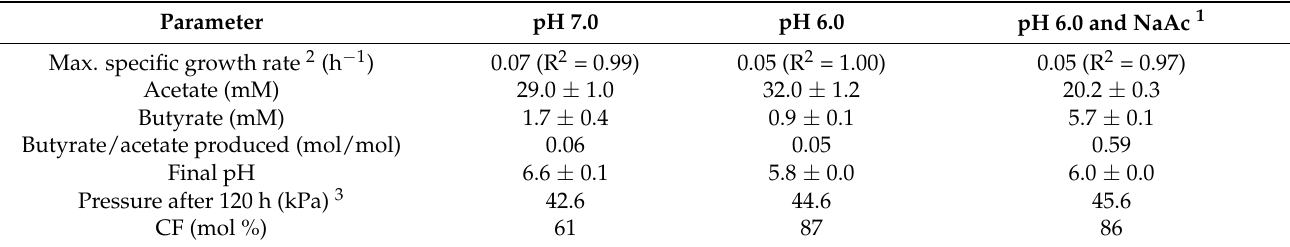
Table 2. Growth rate, acetate and butyrate production, pH and pressure decrease achieved in the culture of B. methy- lotrophicum with Syngas A, at pH 7.0 and pH 6.0, with or without medium supplementation of the culture medium with sodium